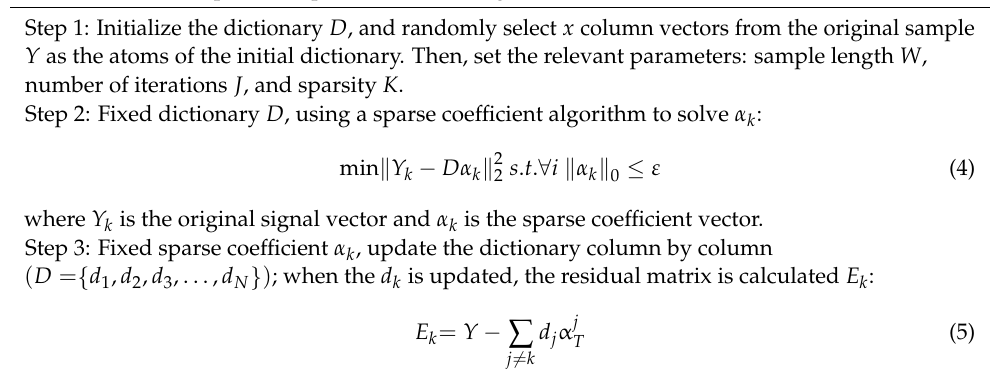
Algorithm 1. The specific steps of the K-SVD algorithm